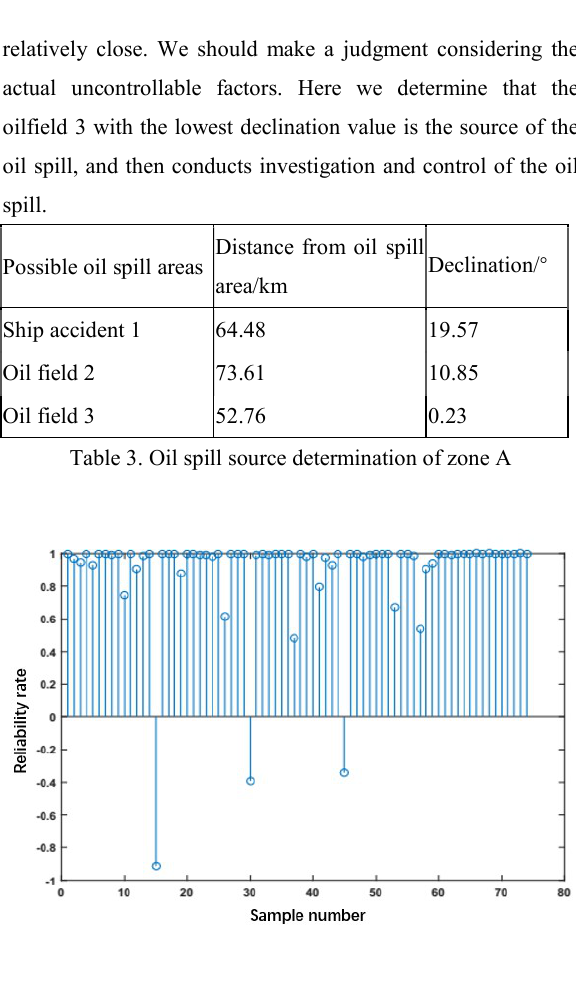
Figure 6. Result of Bayesian classifier